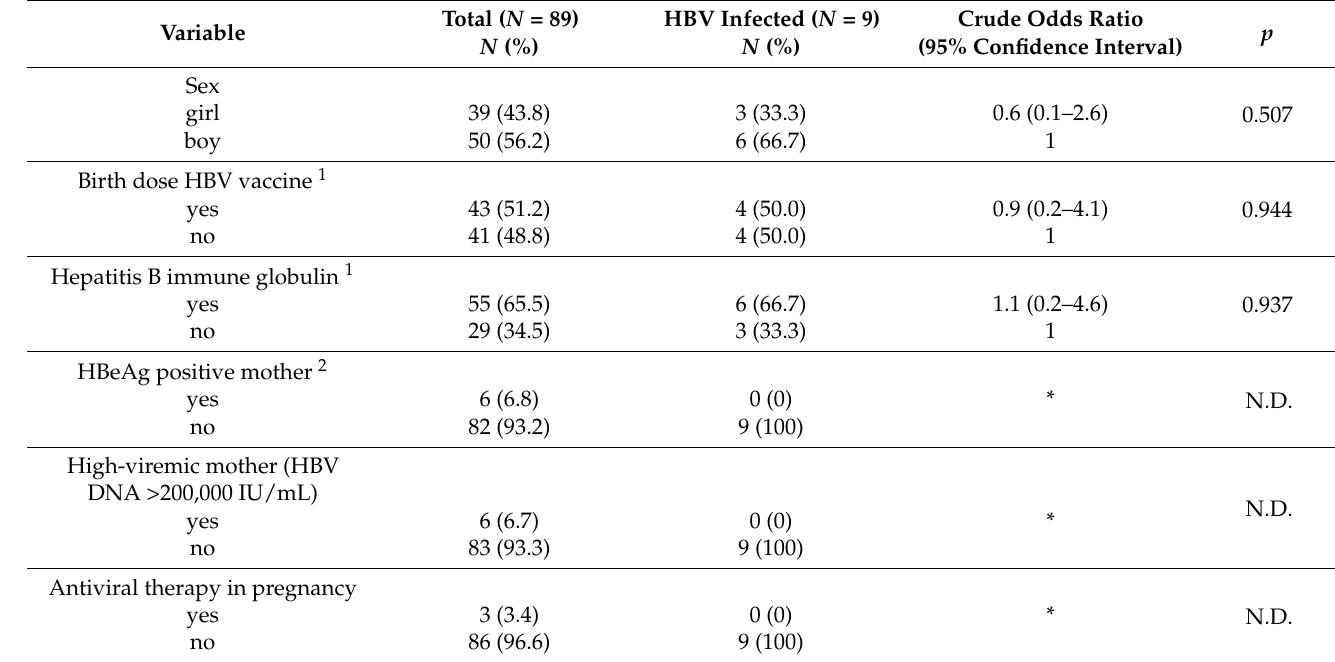
Table 5. Factors associated with hepatitis B virus infection in children born to HBsAg positive mothers, Addis Ababa,